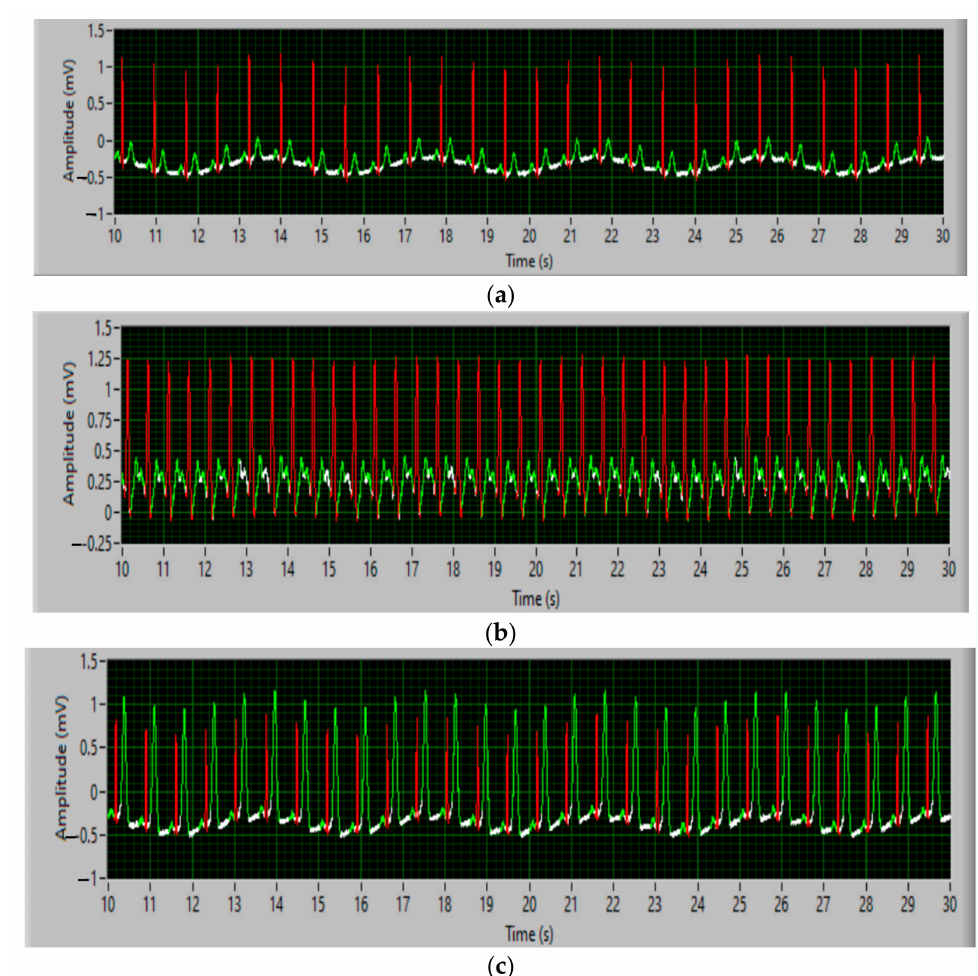
Figure 6. QRS cardio analysis for: ( a ) clinically normal; ( b ) hypotension; ( c )